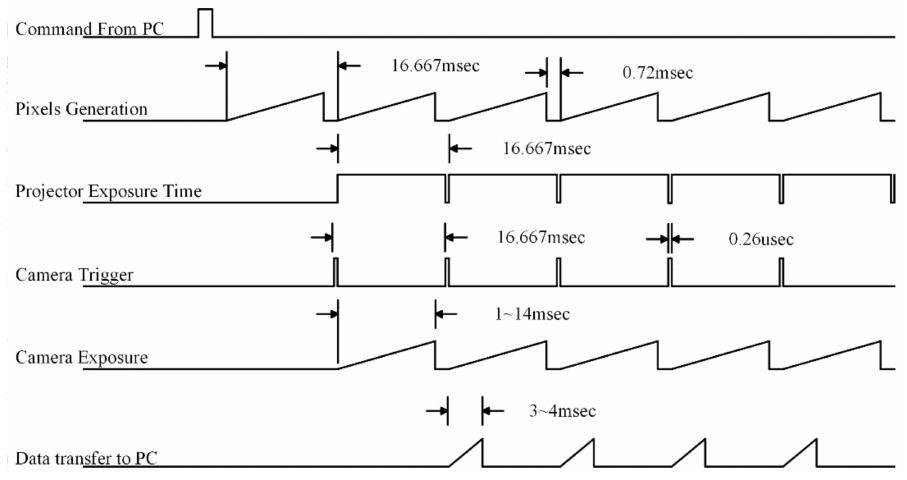
Figure 5. Timing diagram for projector screen refresh rate matched with camera frame rate.